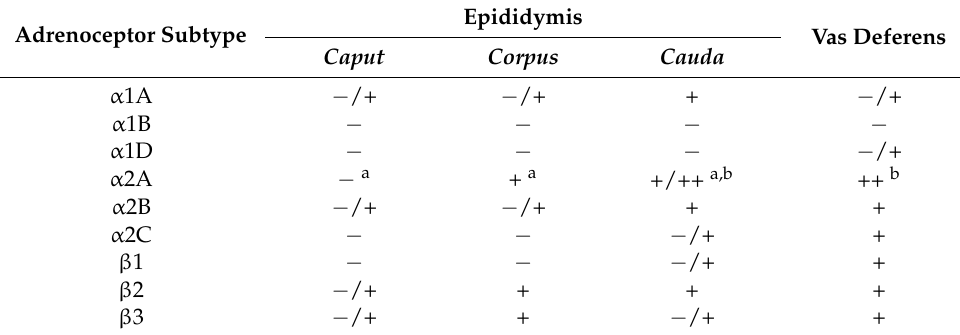
Table 1. The semiquantitative assessment of the intensity of reaction in the muscular layer of the epididymal tubuli/vas deferens in domestic cats. The data are presented as the median score of the intensity of immunostaining ( n =